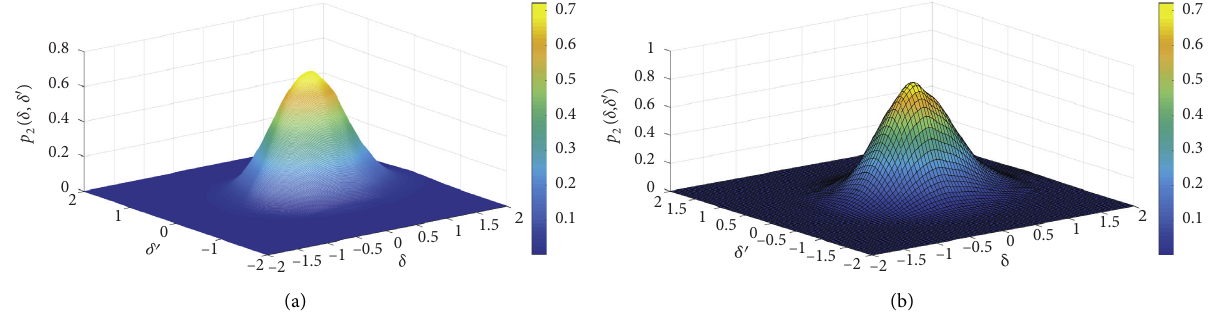
Figure 10: Comparison of displacement and velocity united PDF of HATNPO. (a) Theoretical solution. (b) Numerical